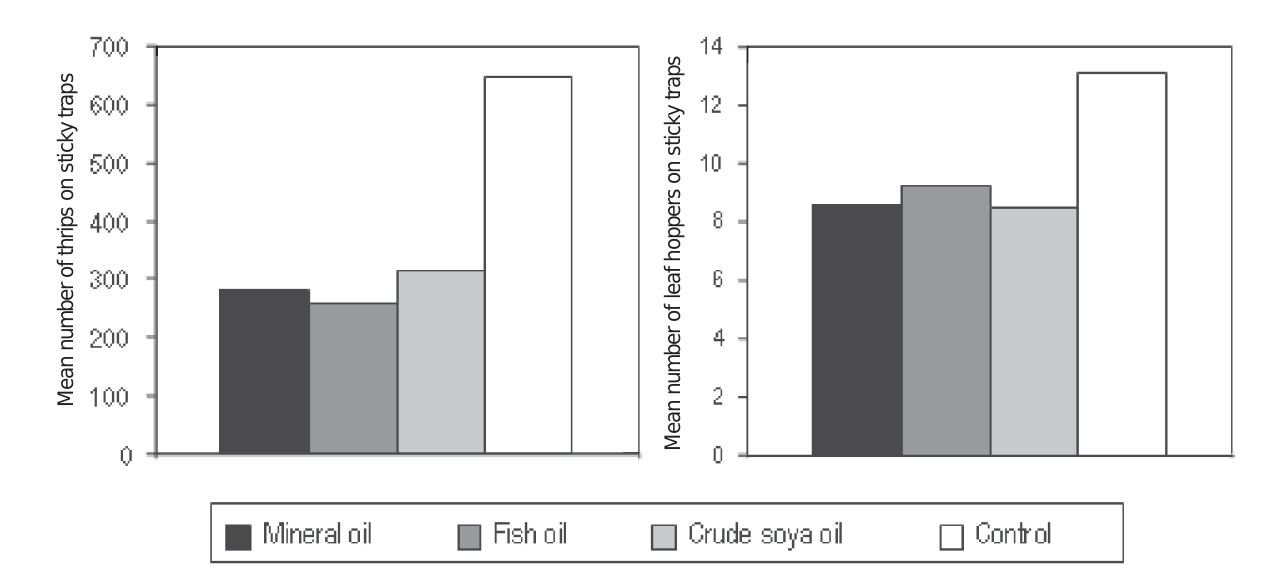
Fig. 5. Average number of insects captured over a three-day-period (1–3 July) on both sides of sticky traps placed in the central area of field plots treated with oils, and control plots. A) Leaf-hopper on yellow traps; B) thrips on blue